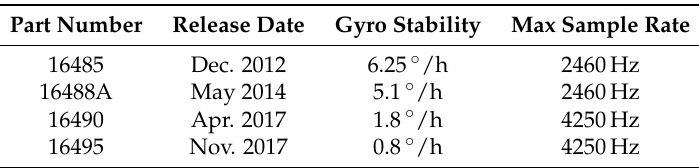
Table 2. ADIS IMU product line gyro stability comparison